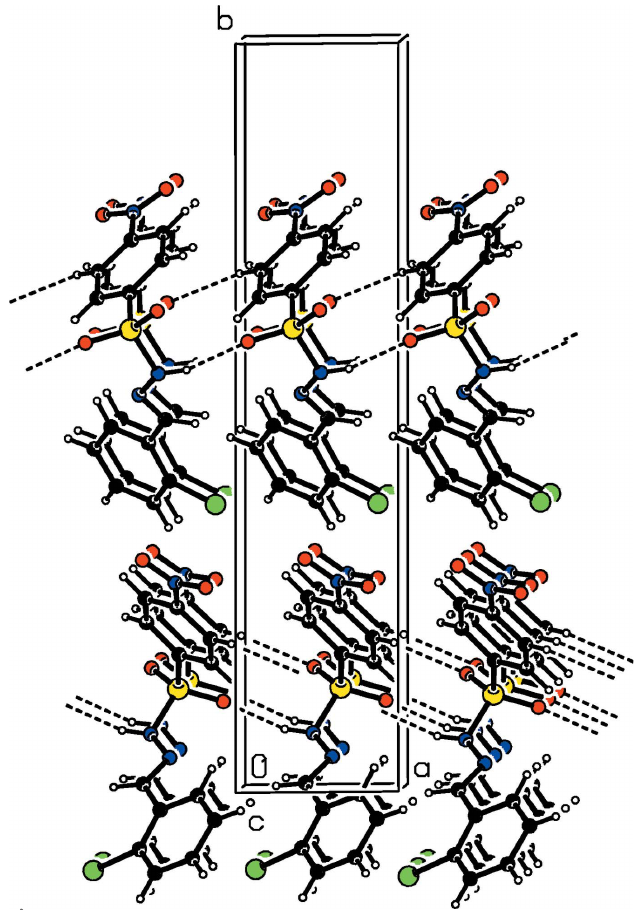
Figure 5 The crystal packing of compound (I), viewed along the c axis, with hydrogen bonds shown as dashed lines.